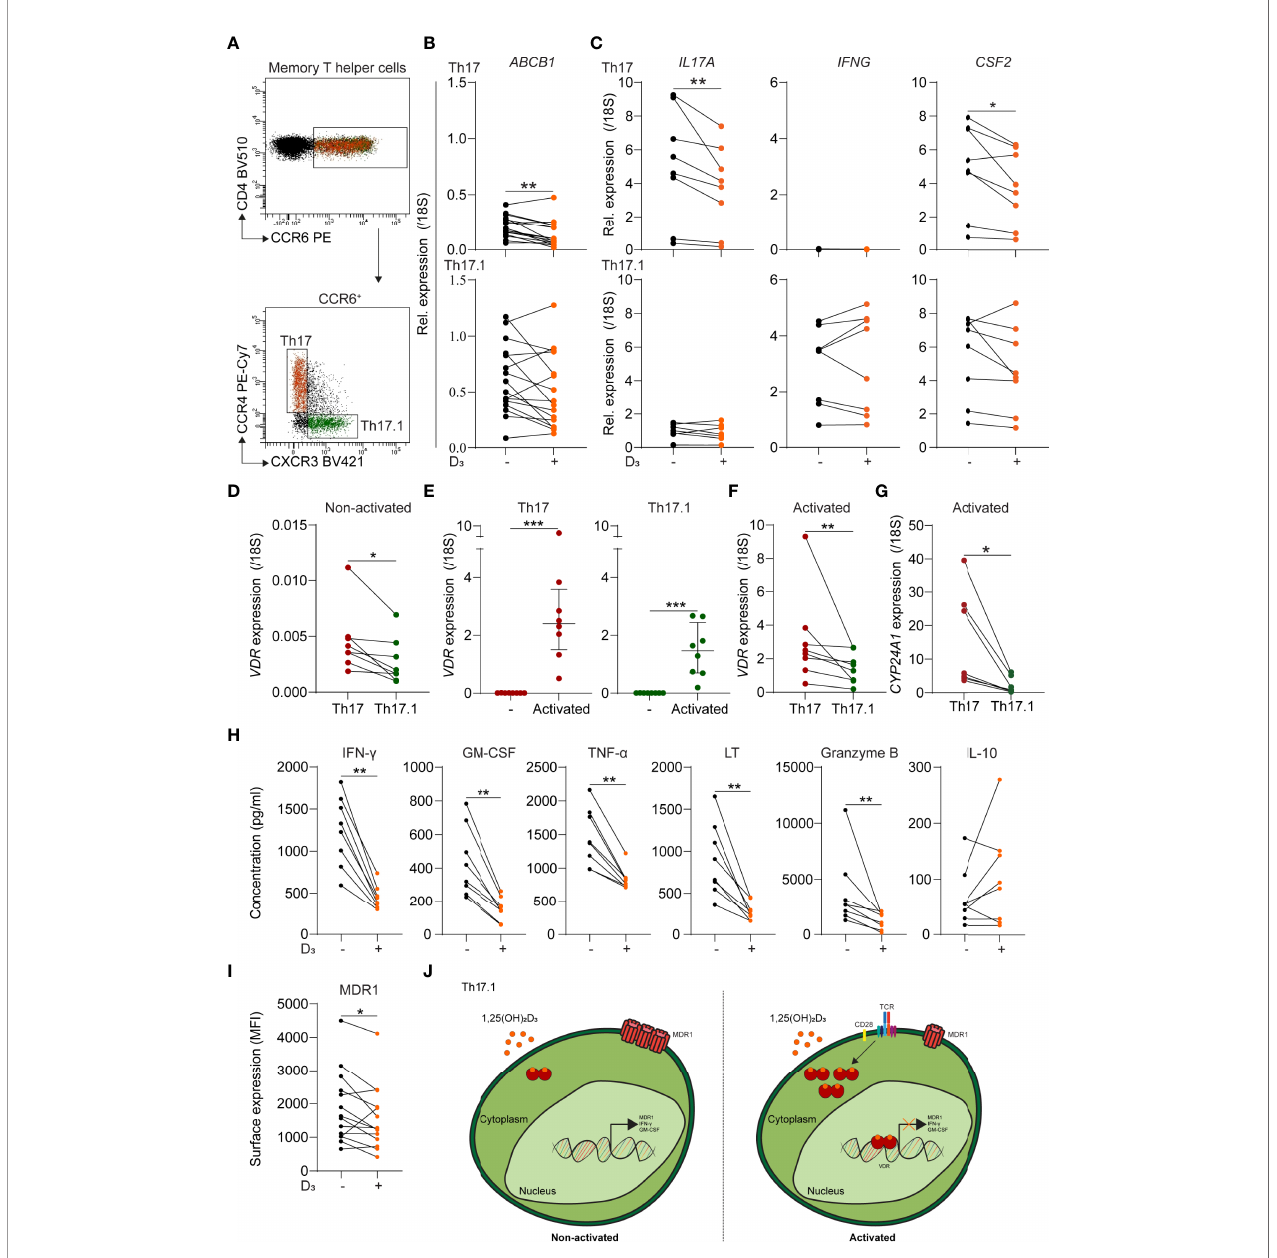
FIGURE 1 | The sensitivity of MDR1 low Th17 and MDR1 high Th17.1 cells to 1,25(OH) 2 D 3. (A) FACS plot showing representative gating for CCR6 + memory T helper (CD4 + CD45RA - CD25 low ) subsets Th17 (CCR4 + CXCR3 - ) and Th17.1 (CCR4 -/dim ). (B) Relative ABCB1 expression for healthy donor Th17 and Th17.1 cells as determined by qPCR ( n = 16 per group). (C) Relative IL-17A, IFNG and CSF2 expression for healthy donor PMAionomycin and anti-CD3/CD28-stimulated Th17 and Th17.1 cells before and after 1,25(OH) 2 D 3 exposure as determined by qPCR ( n = 7 per group). (D) Relative VDR expression for healthy donor non-activated Th17 and Th17.1 cells as determined by qPCR ( n = 7 per group). (E) Relative VDR expression for healthy donor non-activated versus anti-CD3/CD28 activated Th17 and Th17.1 cells, including a comparison for these activated Th17 and Th17.1 cells (F) , as determined by qPCR ( n = 8 per group). (G) Relative CYP24A1 expression for healthy donor PMAionomycin and anti-CD3/CD28-stimulated Th17 and Th17.1 cells after 1,25(OH) 2 D 3 exposure as determined by qPCR ( n = 7 per group). (H) Amount (pg/ml) of IFN- g , GM-CSF, TNF- a , LT, granzyme B, and IL-10 measured in the supernatants of healthy donor anti-CD3/CD28-stimulated Th17.1 cells before and after 1,25(OH) 2 D 3 exposure as determined by Luminex ( n = 8 per group). (I) MDR1 surface expression (median fl uorescent intensity) on healthy donor anti-CD3/ CD28-stimulated Th17.1 cells before and after 1,25(OH) 2 D 3 exposure ( n = 13 per group). (J) Graphical model displaying the 1,25(OH) 2 D 3 sensitivity of non-activated versus activated Th17.1 cells. When TCR-activated, Th17.1 cells increase their VDR expression resulting in 1,25(OH) 2 D 3 -signaling and a decrease in their pro- in fl ammatory (IFN- g + GM-CSF + ) and MDR1-expressing phenotype. Lines represent paired observations for cells from the same donors. Data were compared using either Wilcoxon rank-sum or (E) Mann-Whitney U tests. * p < 0.05, ** p < 0.01 and *** p < 0.001. “ D 3 = 1,25(OH) 2 D 3 ” , “ MDR1 ” , multidrug resistance protein 1; “ MFI, median fl uorescence intensity ” ; “ 1,25(OH) 2 D 3 , calcitriol ” , “ TCR ” , T-cell receptor and “ VDR, vitamin D receptor ”